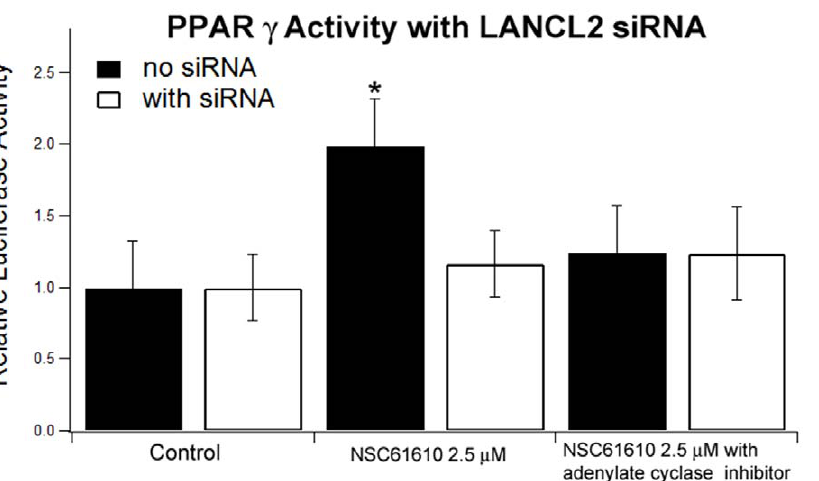
Figure 2. Effect of LANCL2 disruption and cAMP inhibition on PPAR c activation in RAW 264.7 macrophages. Cells were cotransfected with a pTK.PPRE3x luciferase reporter plasmid driven by the PPRE-containing Acyl-CoA oxidase promoter with or without LANCL2 siRNA. Then, cells were treated with vehicle (DMSO) or NSC61610 (2.5 m M), the adenylate cyclase-specific inhibitor 2 9 5 9 -dideoxyadenosine (10 m M). Luciferase activity was normalized to pRL activity in the cell extracts and relative luciferase activity was calculated a ratio of the activity in the treatment wells to control wells. Data are represented as mean 6 standard error. Points with an asterisk indicate that a treatment is significantly different from its control ( P , 0.05